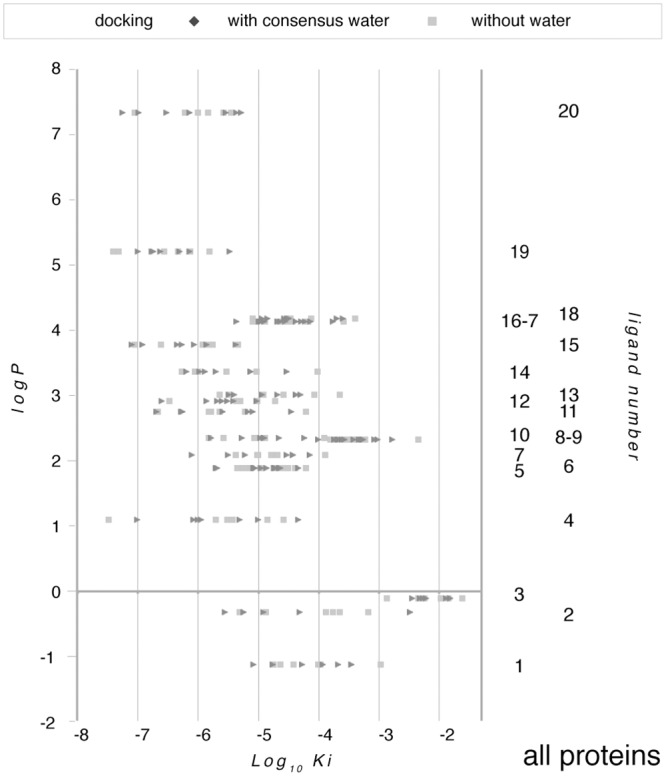
Log10Ki for the interaction of each of the test ligands (in Table 1) with the seven test calycins (in Table 2).Color coding as in Fig 7. Ligand by number as in Table 1.